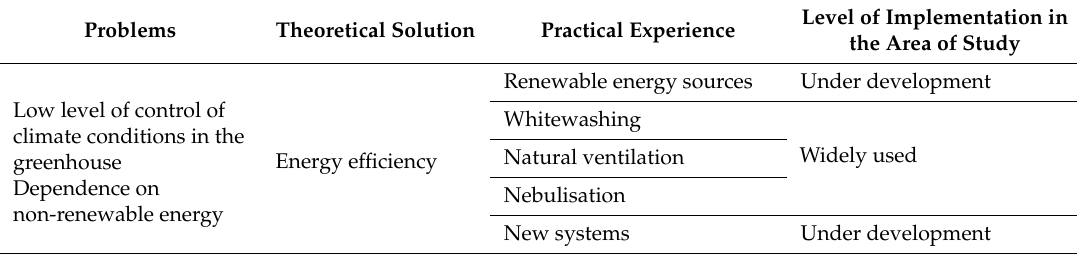
Table 6. Main solutions based on the CE for